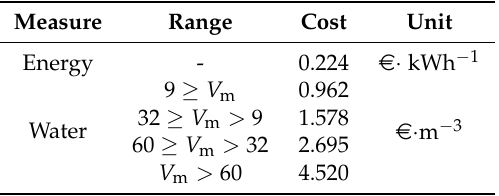
Table 5. Energy and water